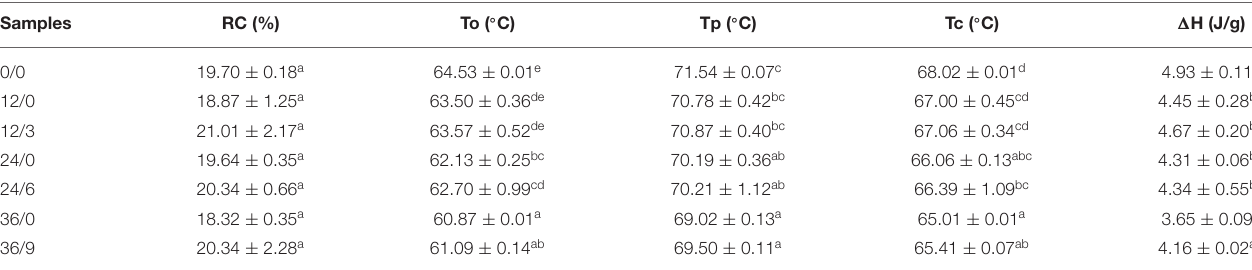
TABLE 1 | The relative crystallinity and thermal parameters (To, Tp, Tc, and 1 H) of whole wheat flour during germination under UV-B radiation.